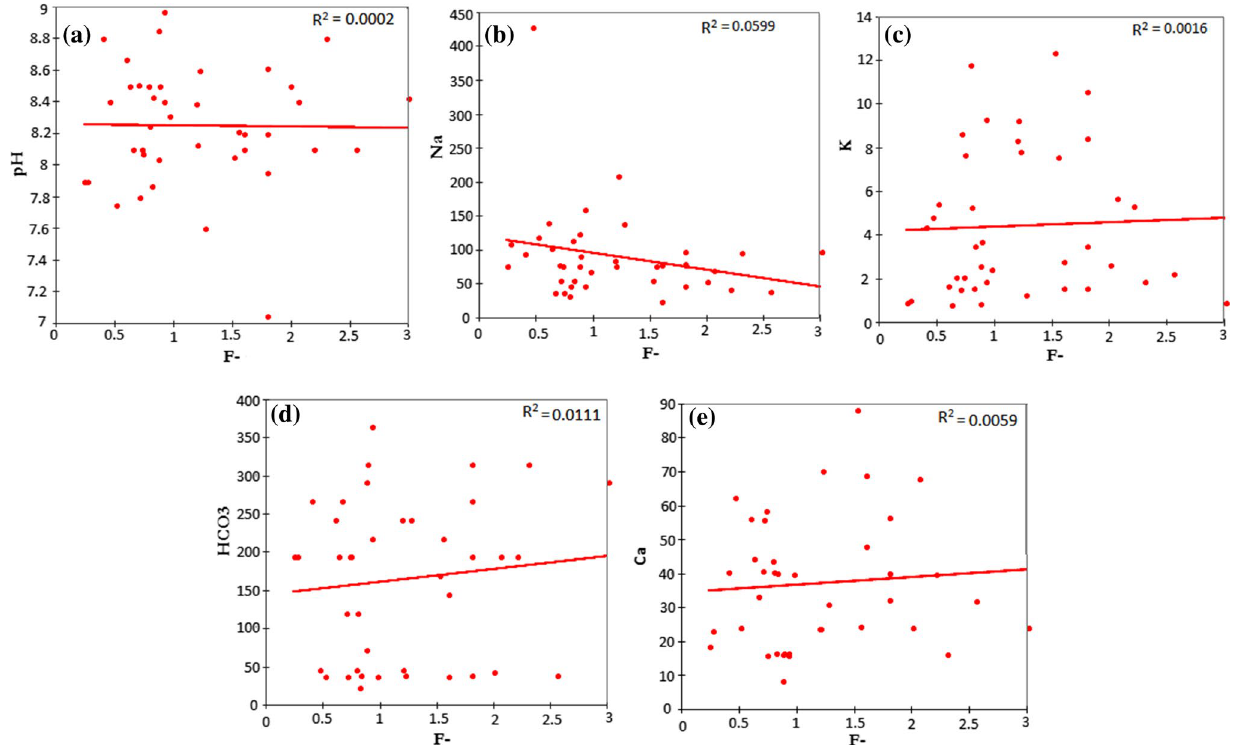
Fig. 4 Fluoride correlation with other physicochemical